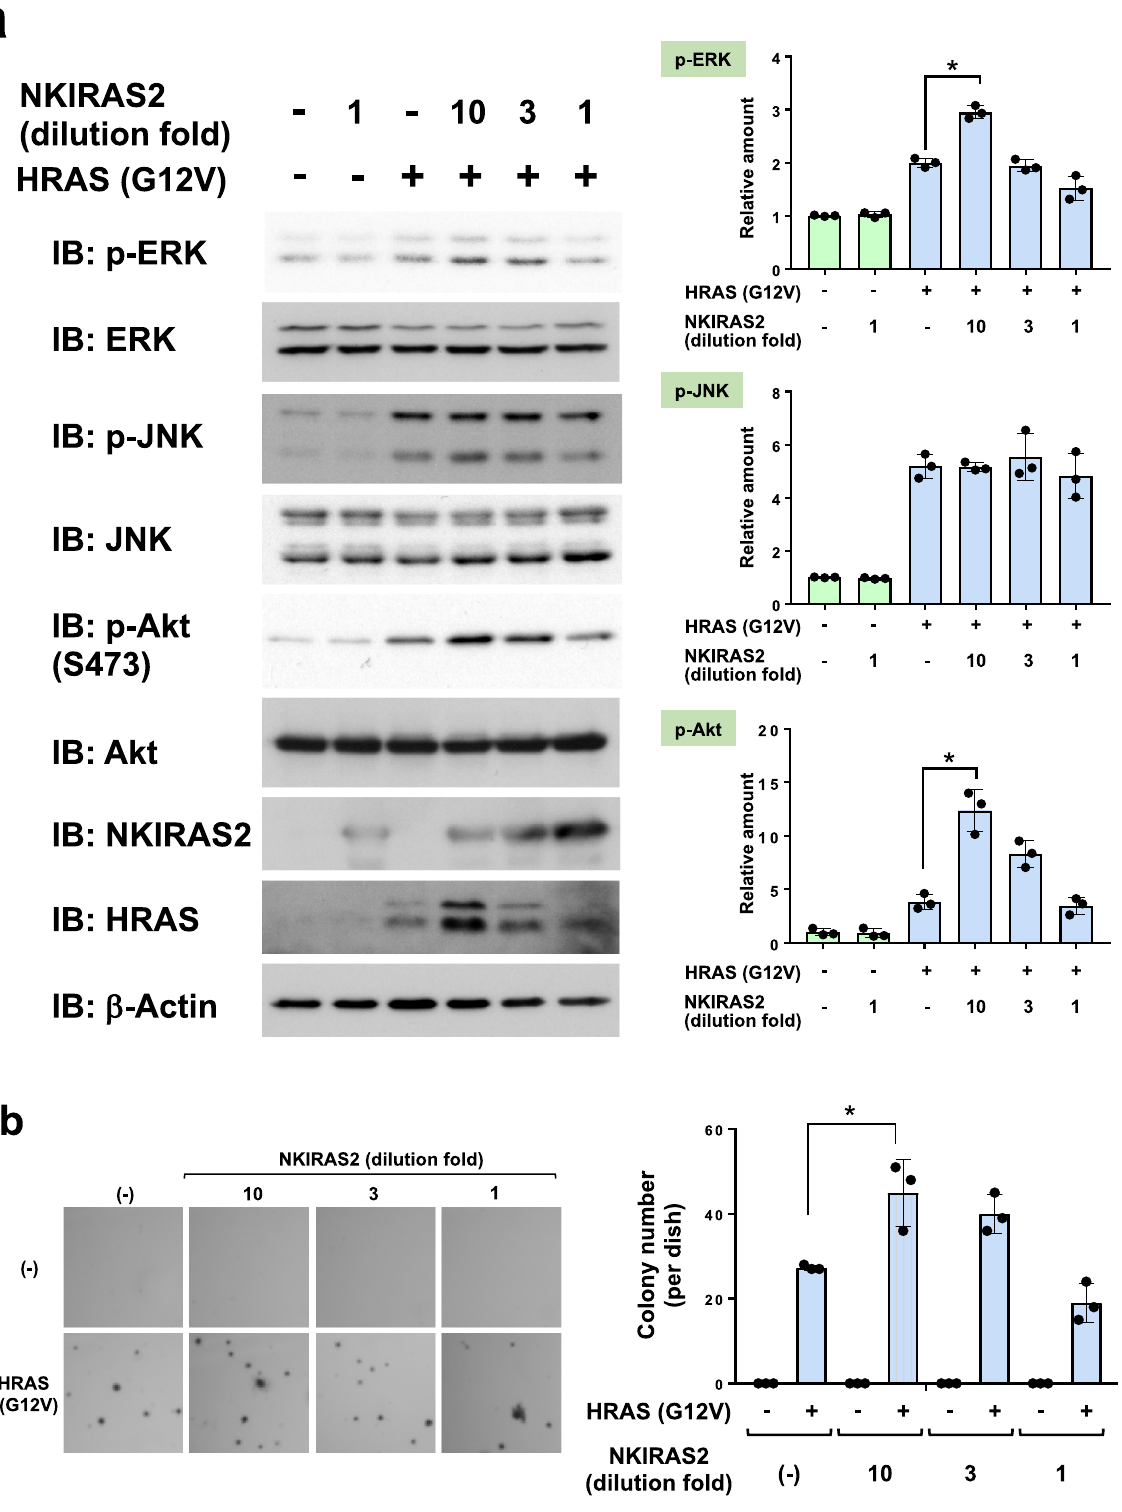
Figure 6. Effect of enforced expression of NKIRAS2 on HRAS (G12V)-induced cellular transformation. ( a ) NIH-3T3 cells were infected with the indicated combination of retroviruses. To analyze dose-dependent effects of NKIRAS2 on HRAS (G12V)-induced signals, the culture supernatant containing NKIRAS2 retrovirus was diluted 1-, 3- and tenfold, and then used to infect the cells. The expression of NKIRAS2 is shown using immunoblotting. The effects of various dosages of NKIRAS2 on HRAS (G12V)-induced activation of ERK, JNK, and Akt are shown. As an internal control, total amounts of ERK, JNK, and Akt are shown. The intensities of protein phosphorylation were shown in the graphs. ( b ) The infected NIH-3T3 cells as in ( a ) were utilized for a soft agar colony formation assay. The number of colonies is shown in the graph. All experiments were performed individually three times, and representative data shown in the graph. The graph shows means with the error bars indicating S.D. (n = 3), and *indicates p <